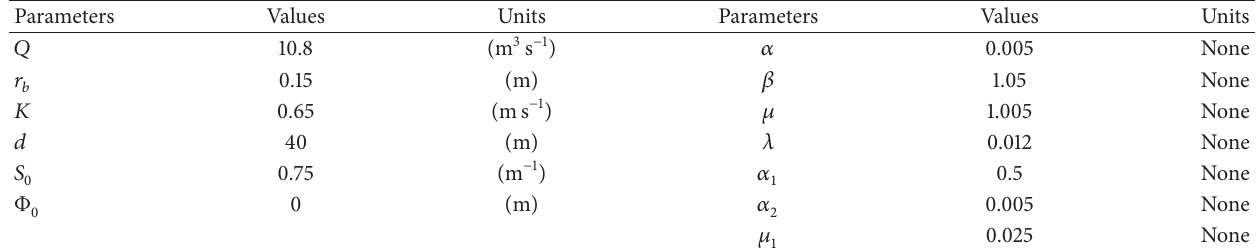
Table 2: Theoretical values.